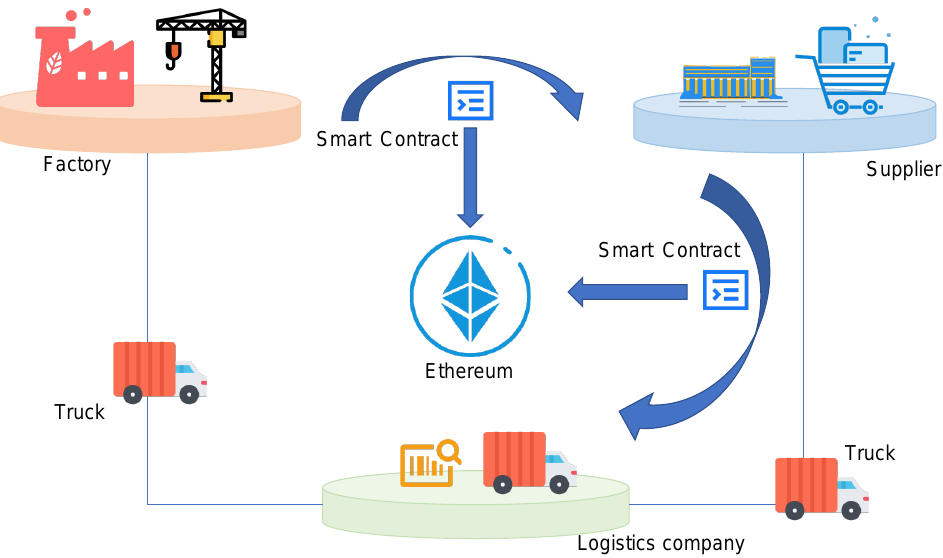
Figure 5. Transaction scenario in the Ethereum commodity